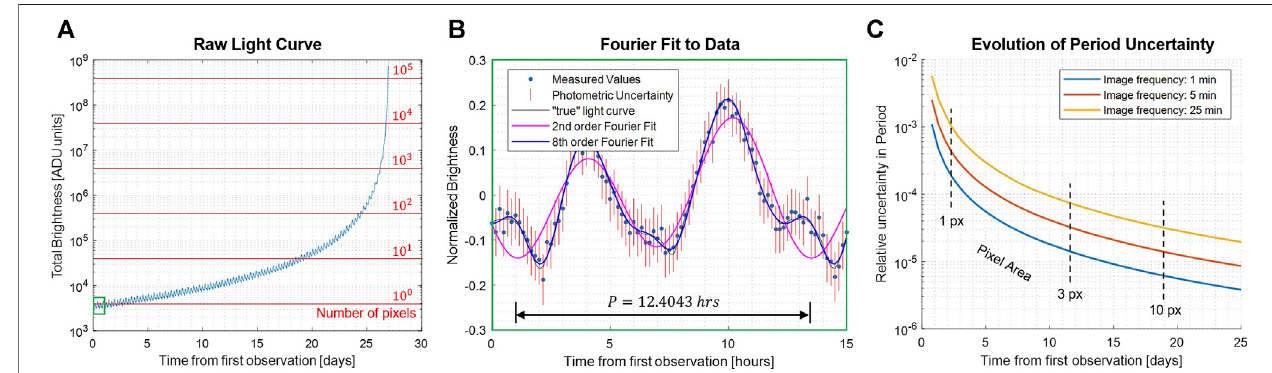
FIGURE 2 | Example of a light-curve analysis for a simulated radial approach of comet 67P, starting from 35,000 km and approaching at 15 m/s with a 5 o solar phase angle and a Hapke re fl ectance model (Hapke, 2012). (A) Raw light curve, showing increasing brightness during approach. (B) Periodicity estimation by Fourier regression, showing raw data (normalized), error bars, and two different-order Fourier models. (C) Evolution of relative-period uncertainty over time for three different imaging frequencies.